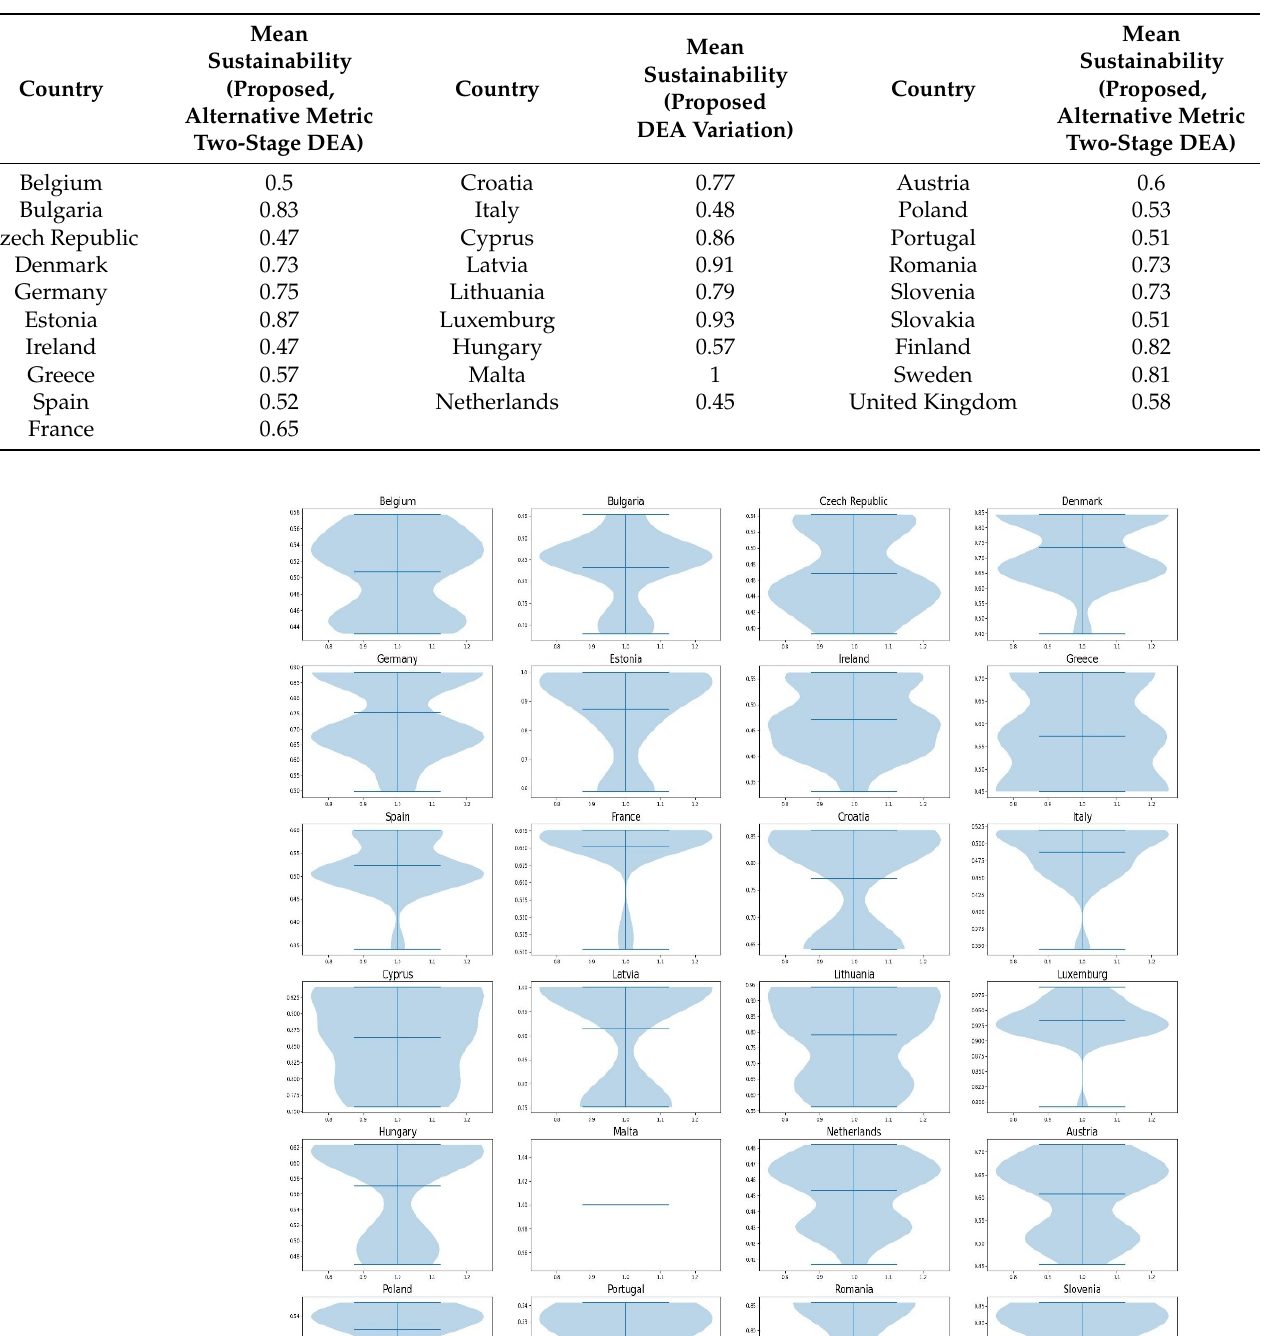
Table 4. Mean sustainability calculated with the proposed DEA model (Equations (11)–(20) and (23)–(25)).